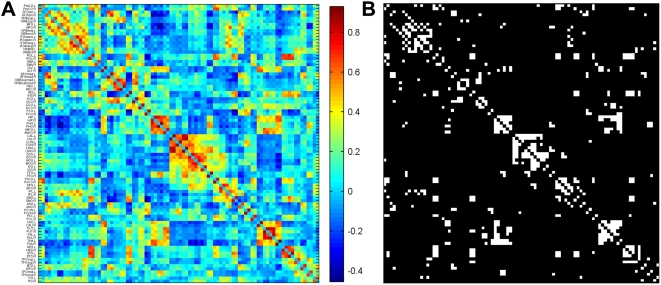
Inter-regional correlation matrix and its functional connectivity backbone.(A) The mean correlation matrix is obtained by averaging a set of correlation matrices across subjects where individual correlation matrix is acquired by calculating Pearson correlation coefficients of time series between every pair of brain regions. The color bar indicates the correlation coefficients. The black arrow in the color bar indicates the threshold value (r = 0.44) that was used to obtain the binarized matrix (B). For the abbreviations of the regions, see Table S1. (B) The functional connectivity backbone (binarized matrix) is obtained by thresholding the mean correlation matrix using a Bonforroni-corrected procedure (P<0.001). Significant correlations between regions are marked in white squares and black squares otherwise. Notably, the binarized matrix describes the basic topological organization of the spontaneous human brain functional network.